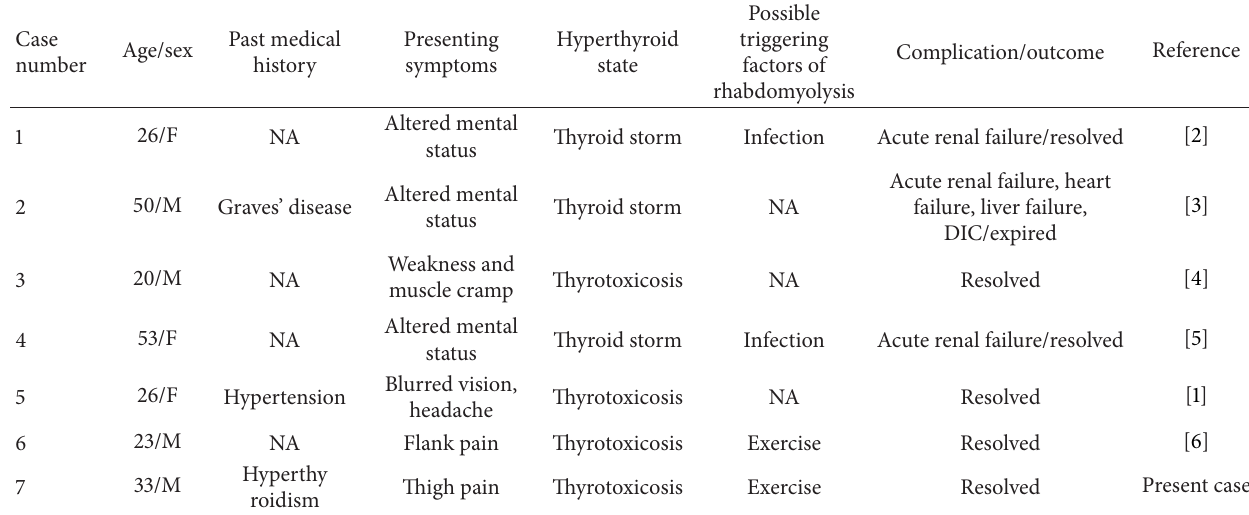
Table 1: Cases of rhabdomyolysis associated with hyperthyroidism published in the medical